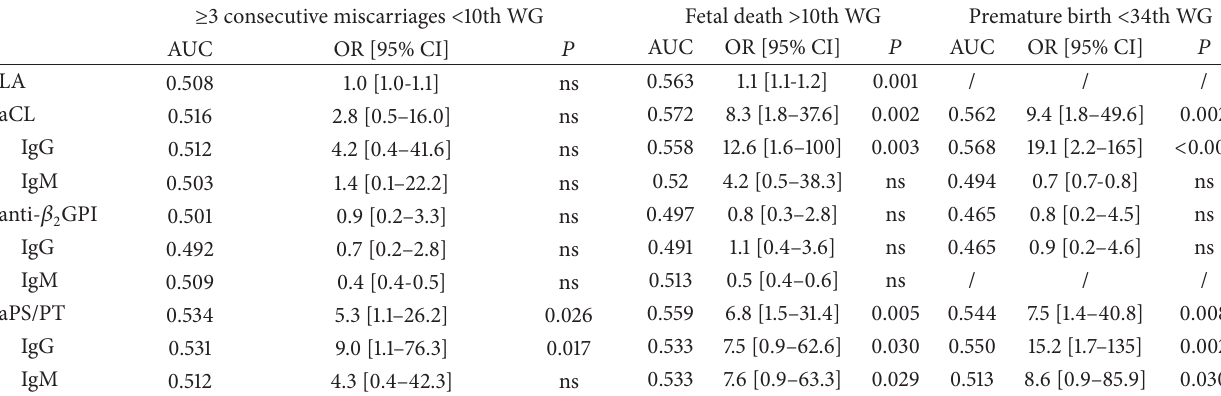
Table 4: Diagnostic accuracy of aPL for different adverse pregnancy outcomes.